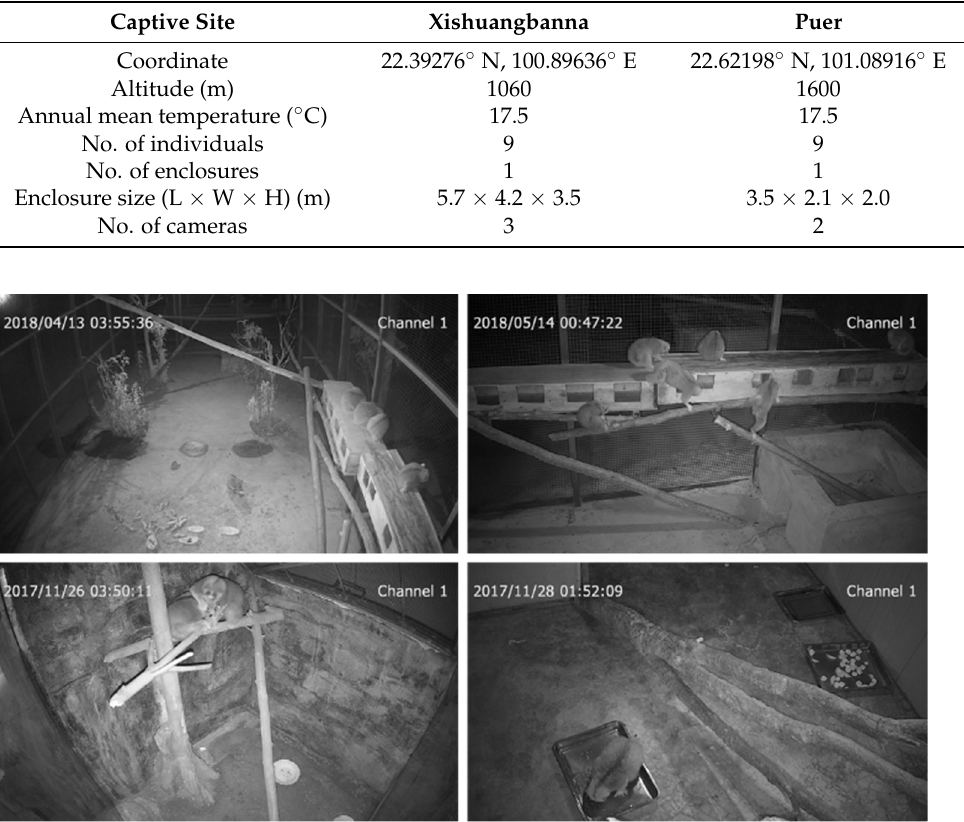
Figure 1. Partial images in the dataset. Table 1. Information about the wildlife rescue centers and the captive Bengal slow